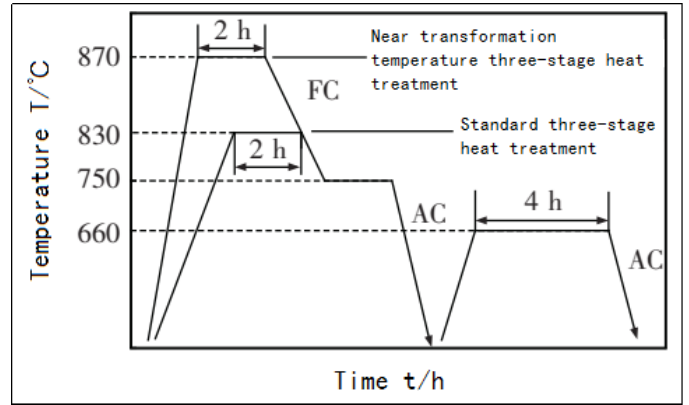
Figure 16. Heat treatment process curve.